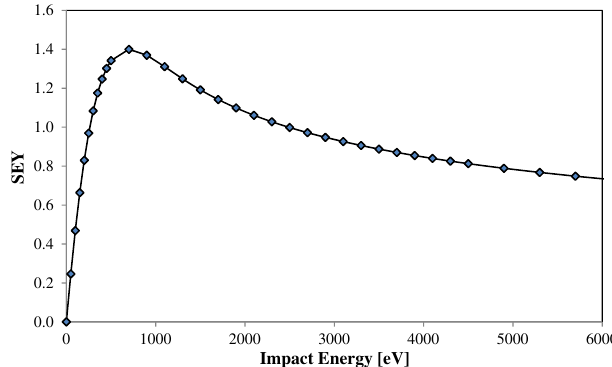
FIG. 10. Secondary emission yield curve for copper used in multipacting simulations.